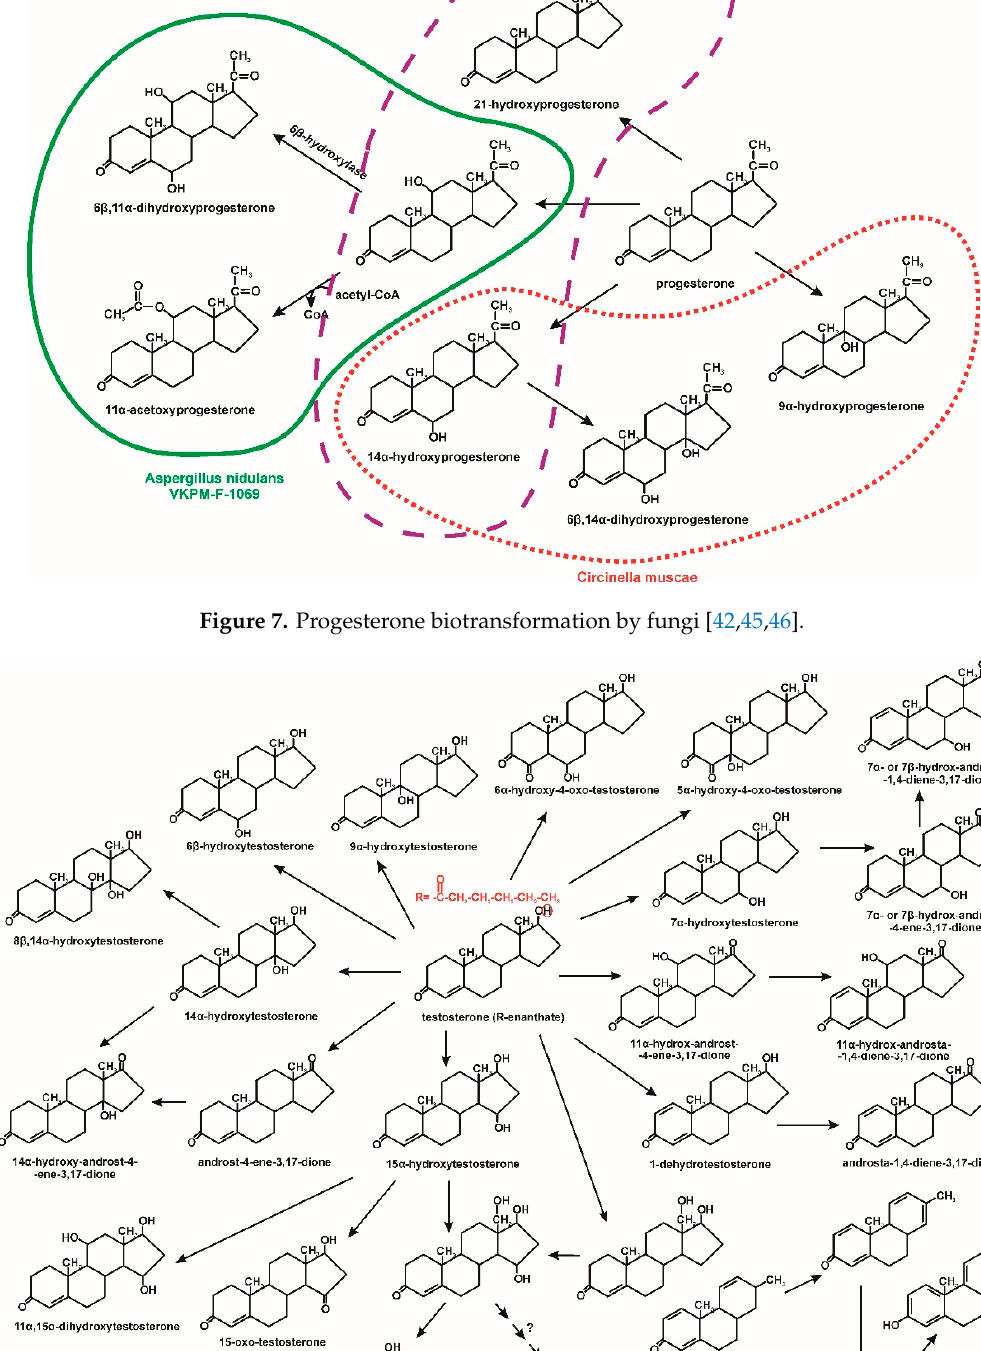
Figure 9. Proposed biotransformation mechanism of 17 α -ethynylestradiol by Lentinula edodes [44].